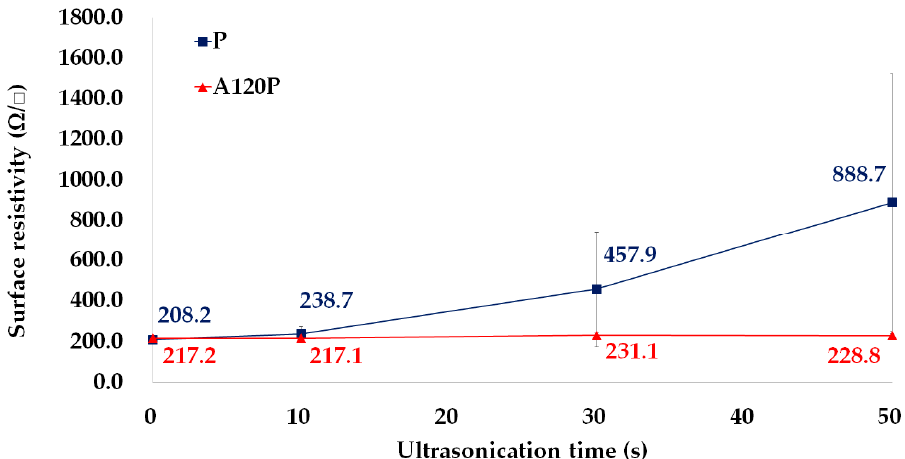
Figure 9. Change of the surface resistivity of a sample covered by only PPy polymerization (P) and a sample treated with an NaOH solution and followed by PPy polymerization (A120P) according to the ultrasonication duration.